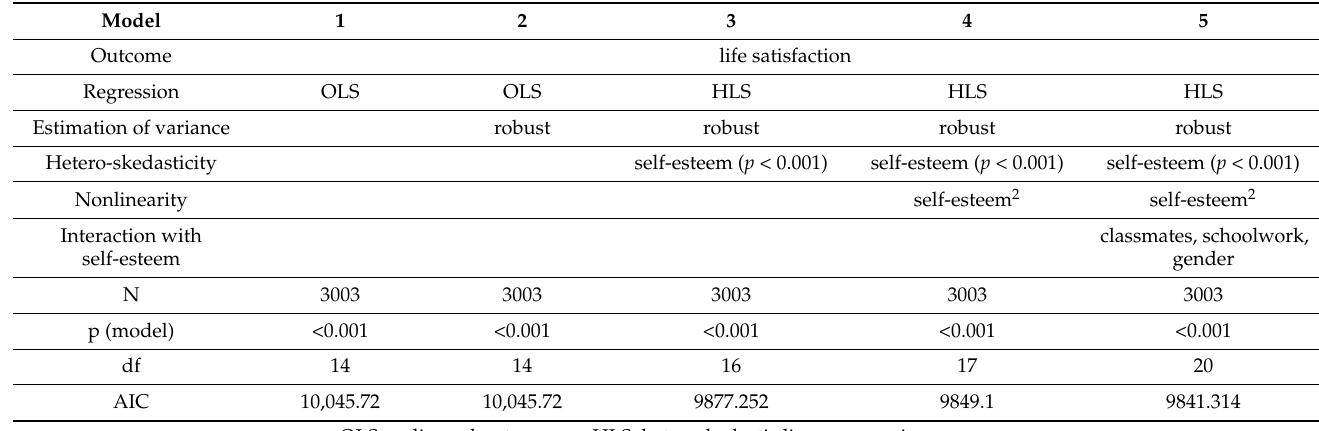
Table 3. Specifics of regression models for predicting life